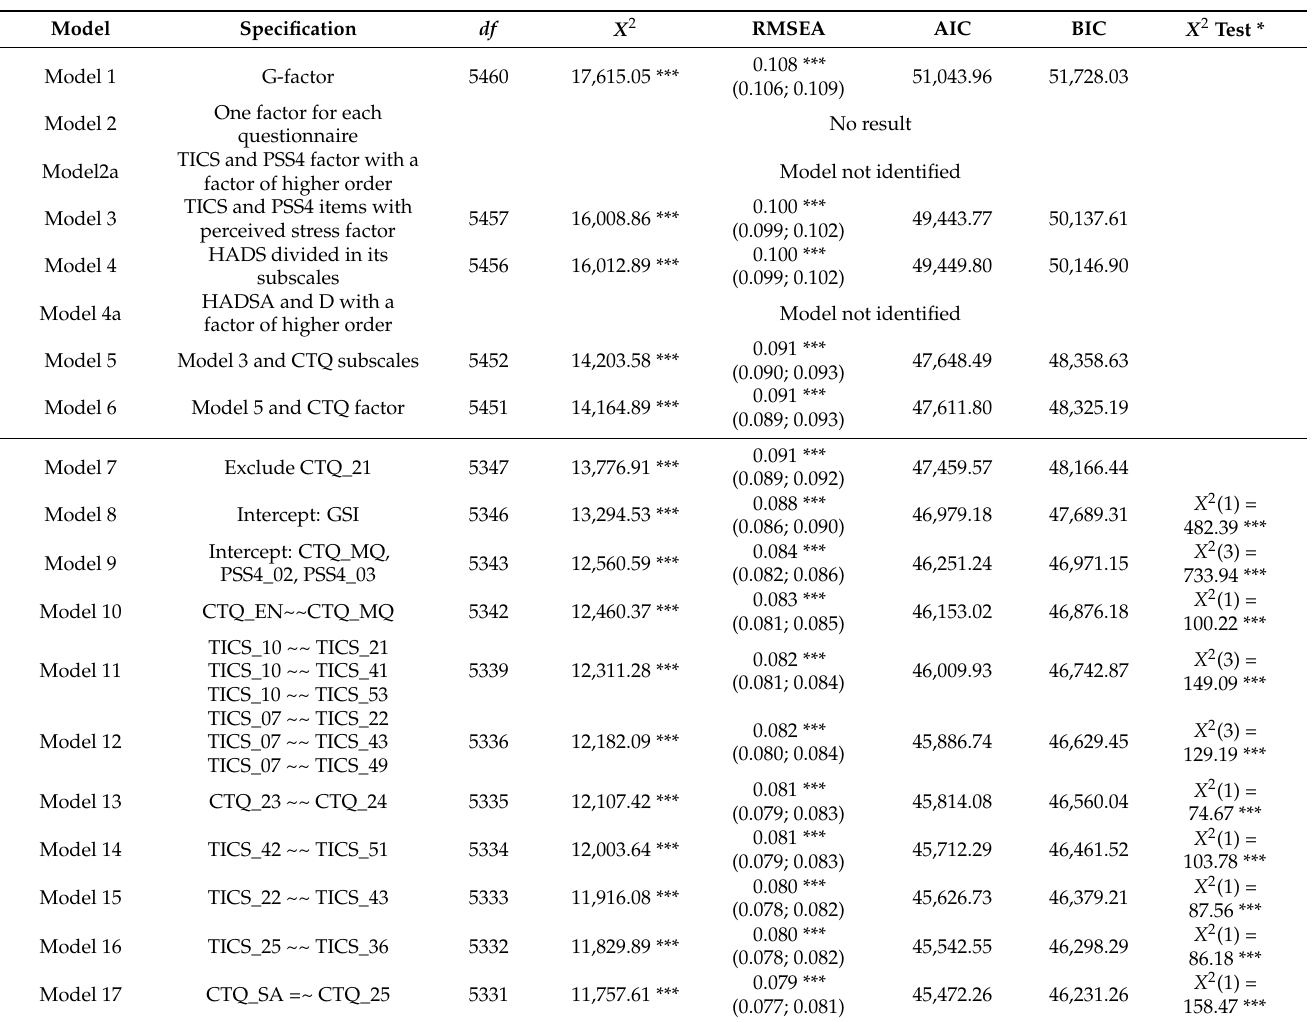
Table 1. Fit indices for all